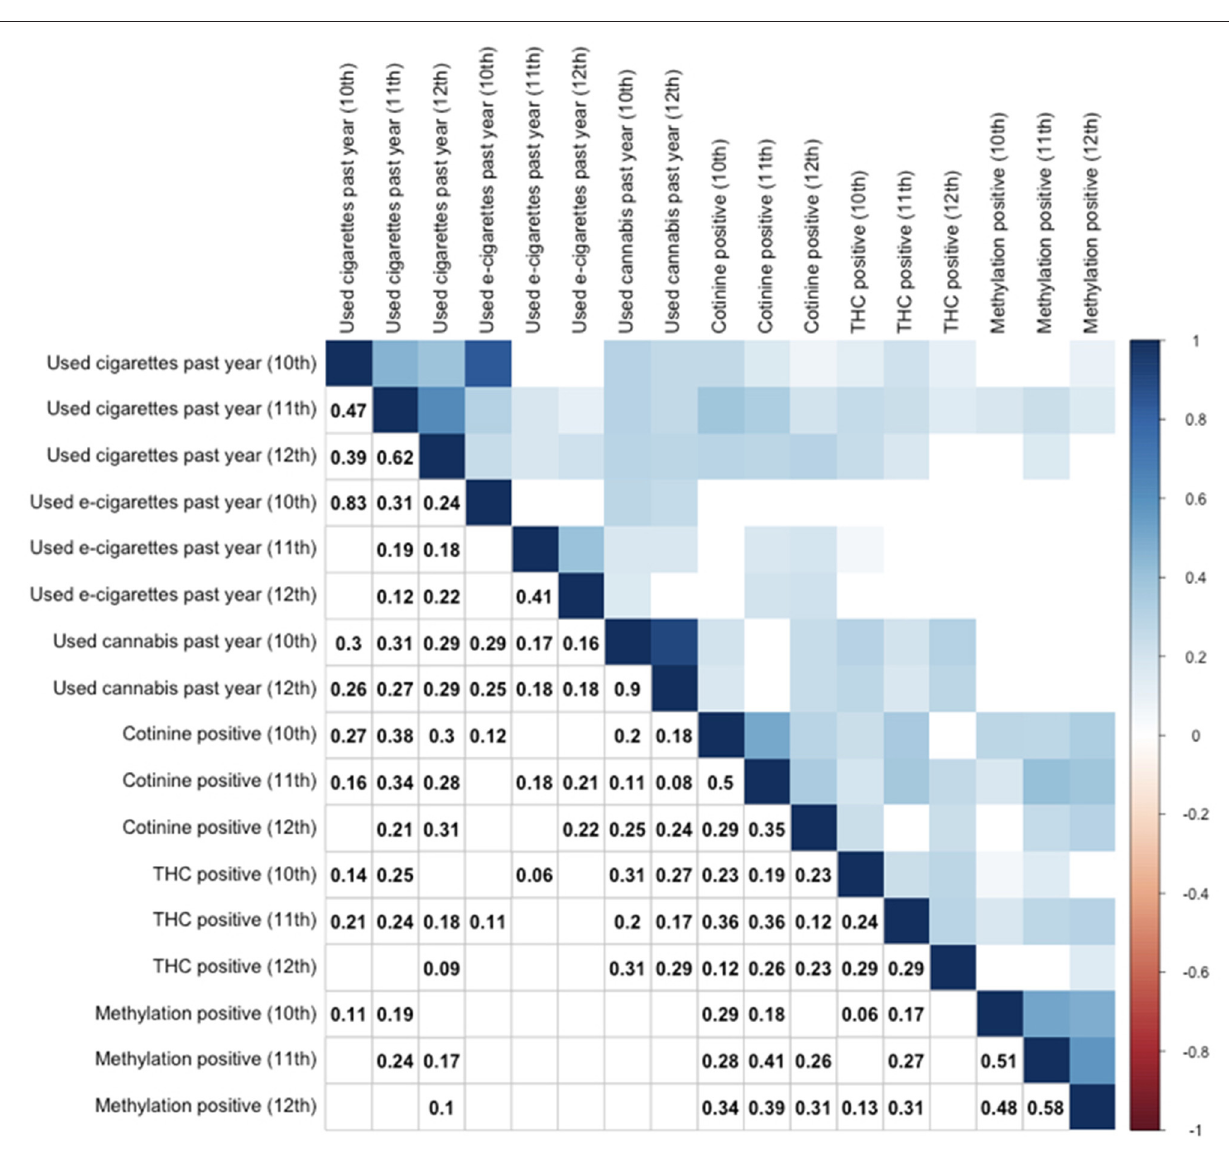
FIGURE 1 | Correlation table for substance use by self-report and biomarker positivity across 10–12th grades. Use of cigarettes, e-cigarettes, and cannabis are by self-report. Other variables reflect objective biomarkers. Cotinine positive indicates serum cotinine ( > 3ng/mL). THC positive indicates serum THC ( > 0.5ng/mL). Only significant ( p < 0.05) correlations are provided numerically (lower triangle) or by color (upper triangle), while non-significant correlations are left as blank squares. Correlation values represent Spearman rank correlation